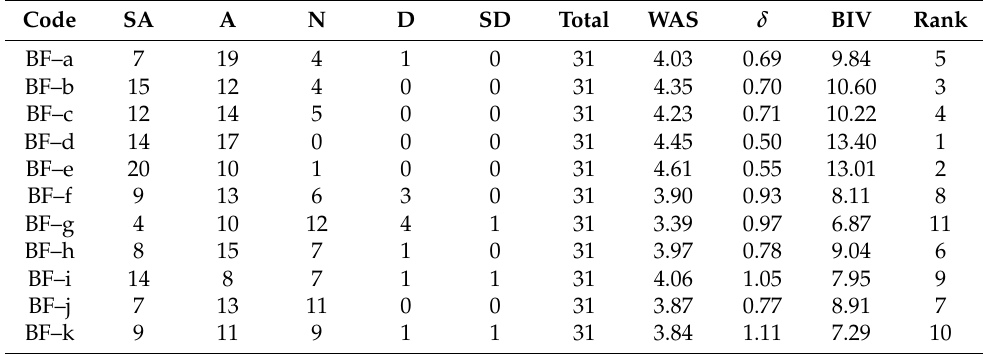
Table 3. Survey responses and calculation of parameter values to beneficial